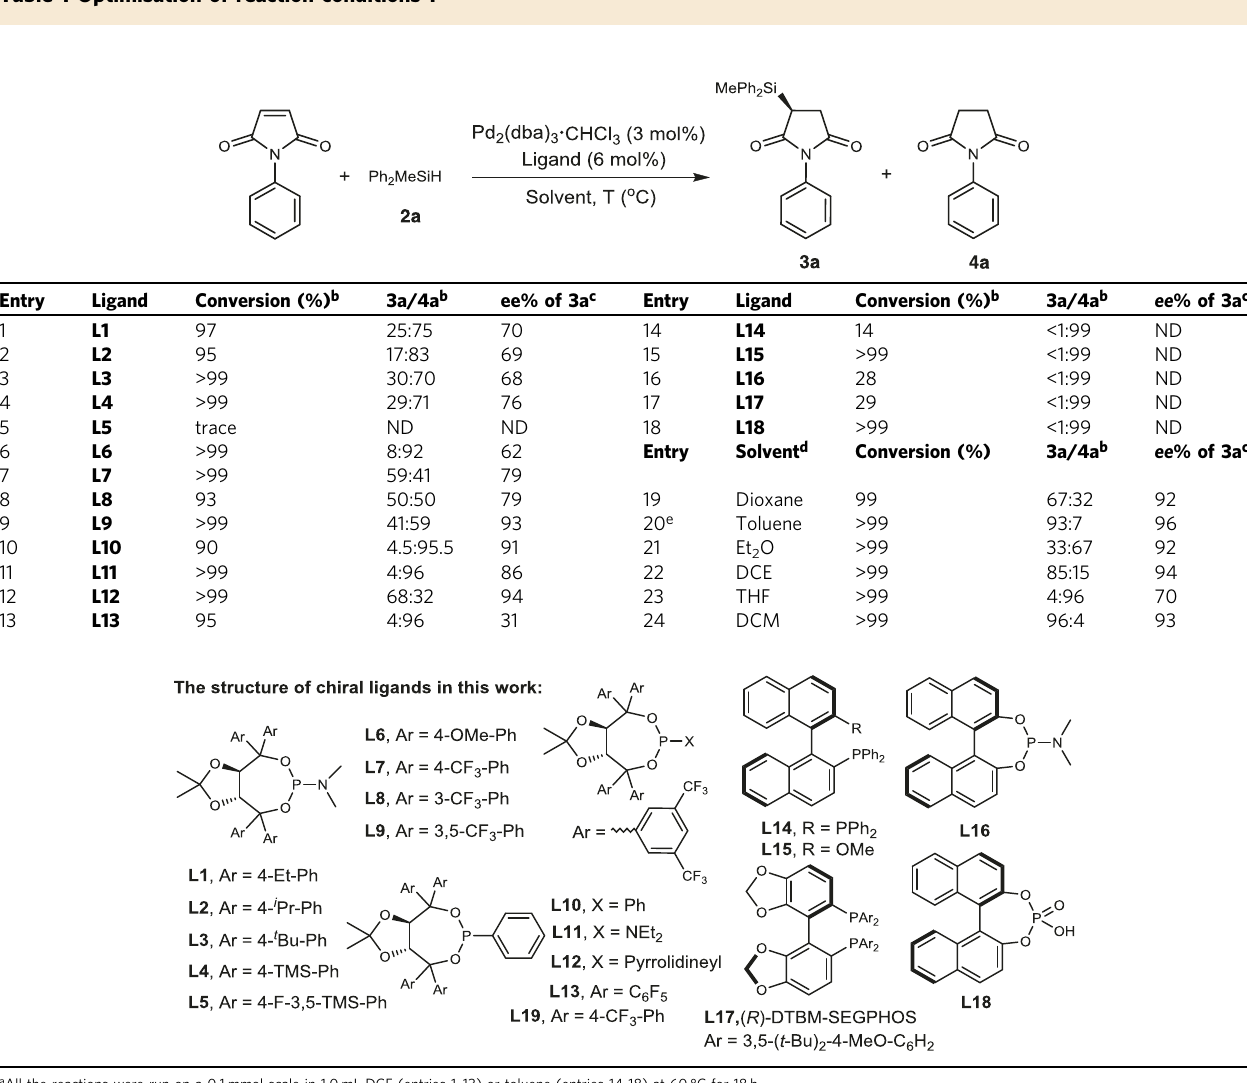
Table 1 Optimisation of reaction conditions a